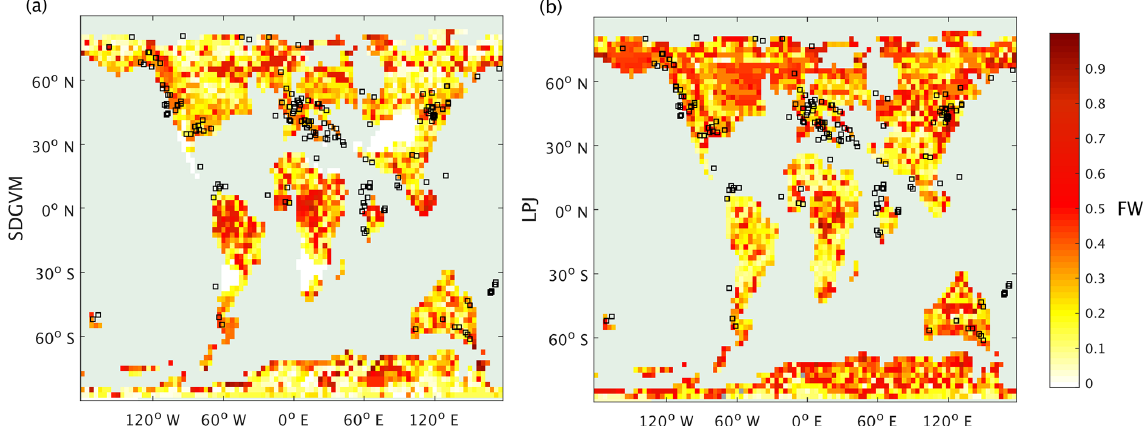
Figure 7. Annual maximum FW calculated by the max3NN method by (a) SDGVM and (b) LPJ for the Eocene climate, compared with coal deposit